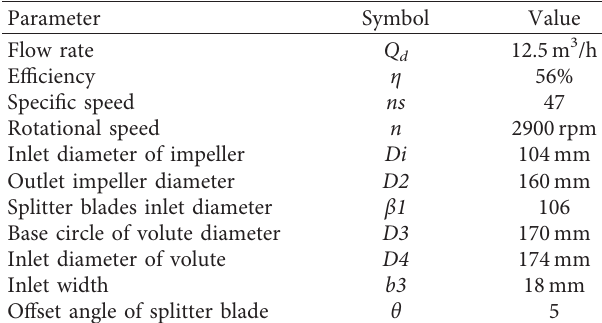
Table 1: Operational and geometric parameters of the selected centrifugal pump